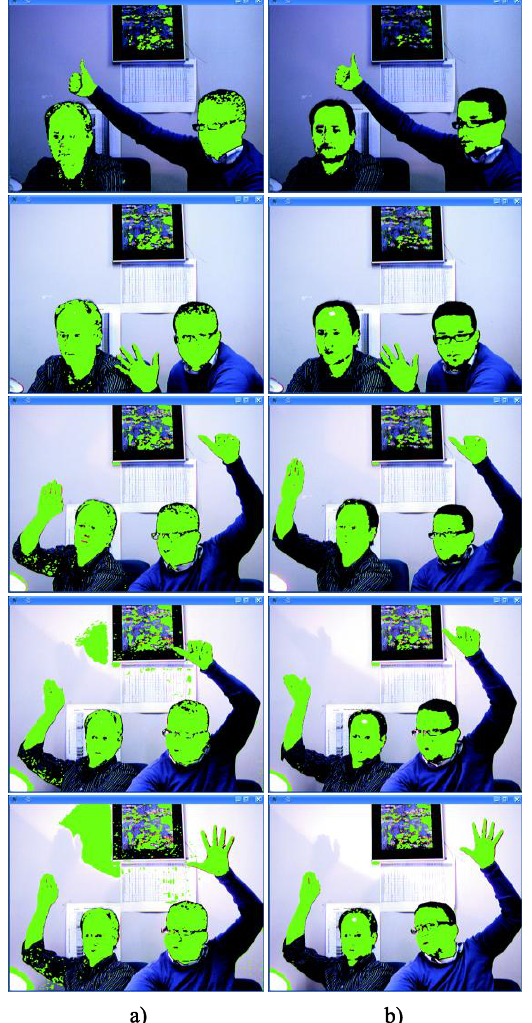
Figure 18. Results of the real-time segmentations with different illumination levels: (a) segmentation of original images captured directly from the camera, (b) segmentation of the images after the colour